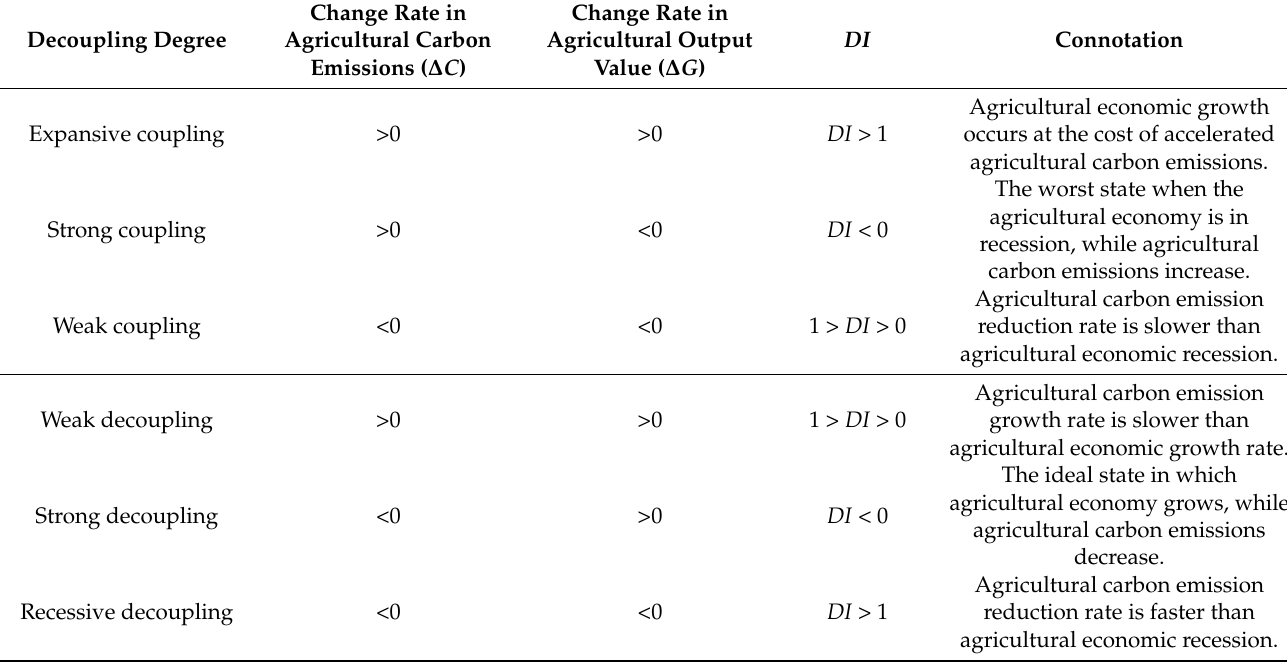
Table 1. Degrees of decoupling agricultural carbon emissions from crop